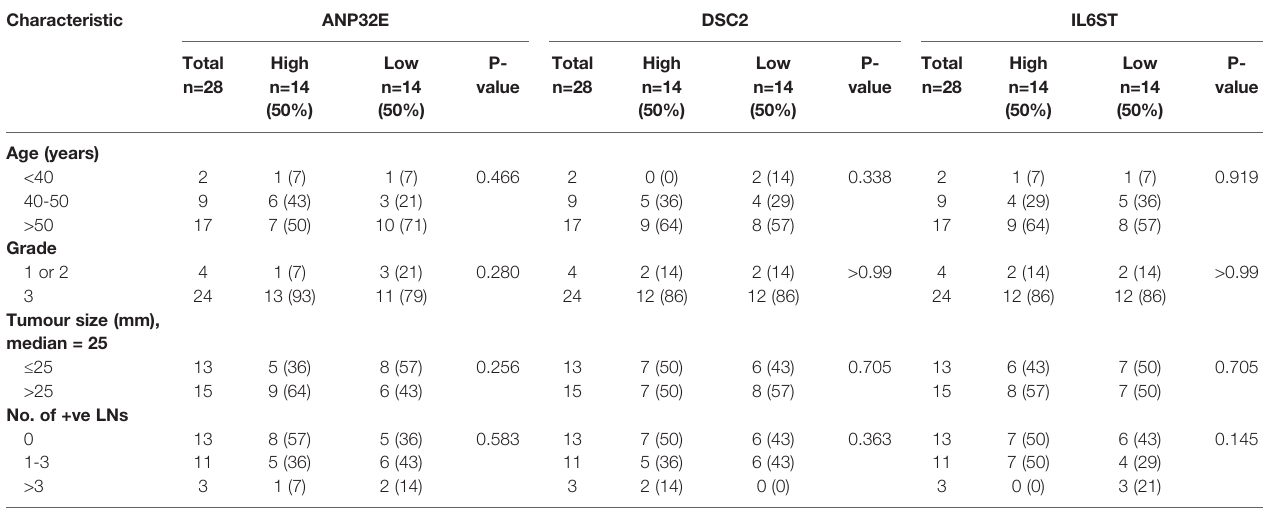
Lymph node status of 1 case is unavailable. Statistical analyses based on chi squared test. A p value of ≤ 0.05 was considered signi fi cant.